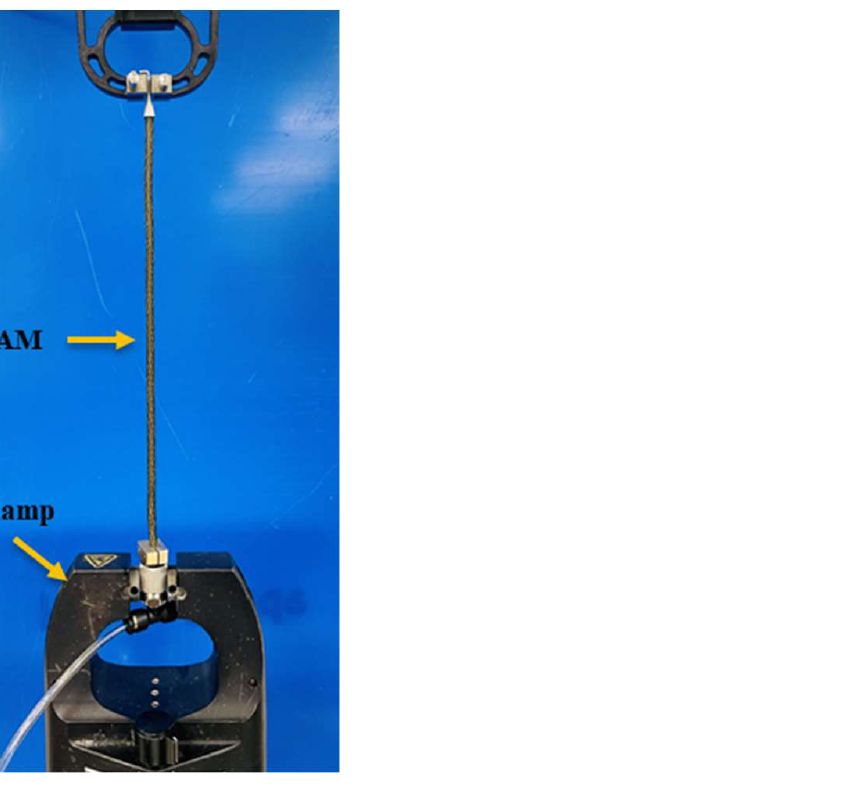
Figure 5. A PAM sample is mounted on an MTS machine with two clamps fixing the two ends.